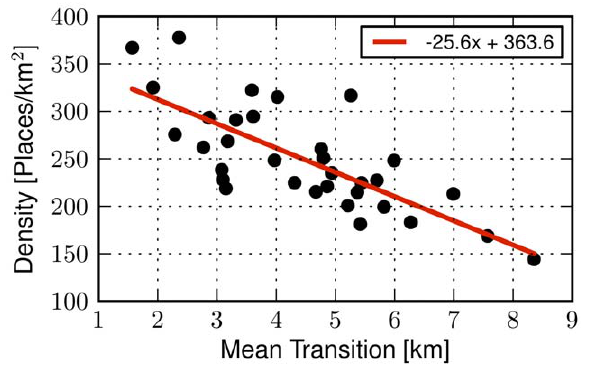
Figure 4. City place densities and mean movement lengths. Scatter plot of the density of a city, defined as the number of places per square kilometer, versus its mean human transition in kilometers. Each datapoint corresponds to a city, while the red line is a fit that highlights the relationship of the two variables ( R 2 ~ 0 : 59 ). A longer mean transition corresponds to the expectation of a sparser urban environment, indicating that the number of available places per area unit could have an impact on human urban travel.